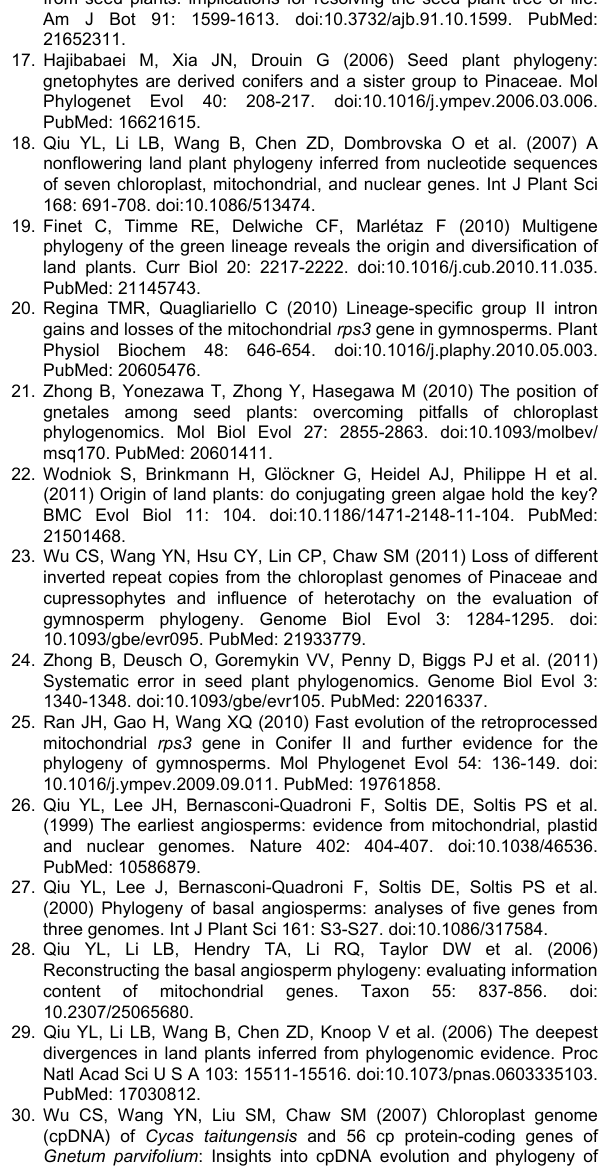
Table S2. Data characteristics for all 47 plastid genes, including number of species per gene, number of nucleotide sites per gene, and percentage of gaps per gene.